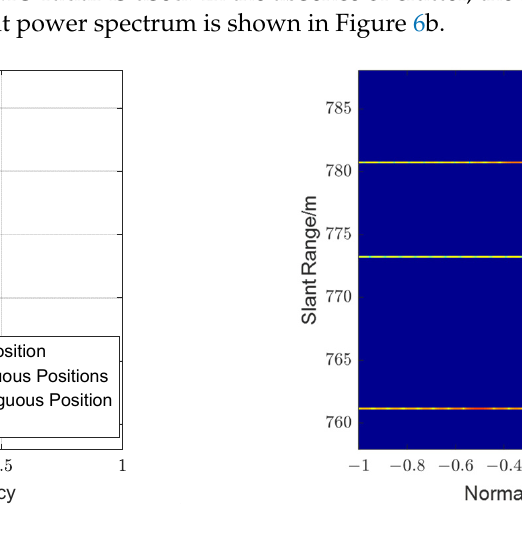
EL: 46° AZ: 90° Table 2. Parameters of the moving target in the simulation experiment No. Range Bin Number Slant Dis- tance (km) Radial Veloc- ity(m/s) Normalized Dop- pler Frequency RCS (m 2 )